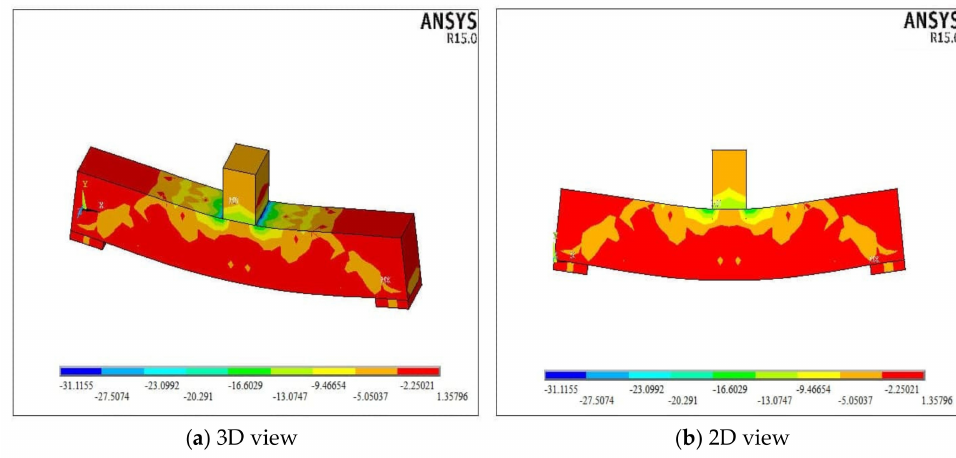
Figure 6. 3D and 2D hydrostatic stress contours of the control beam model B1 at failure.